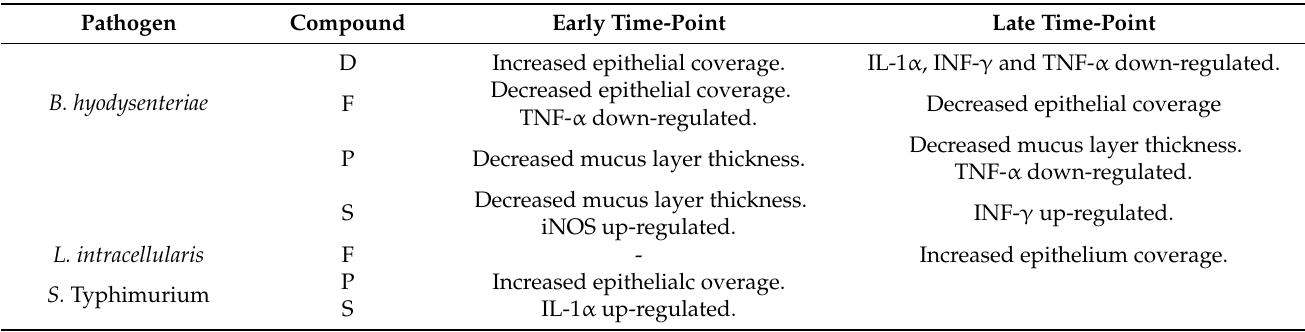
Table 2. Summary of significant findings when comparing the treatment group (TG) vs. pathogen control group (PCG) across the different pathogen-compound (C)